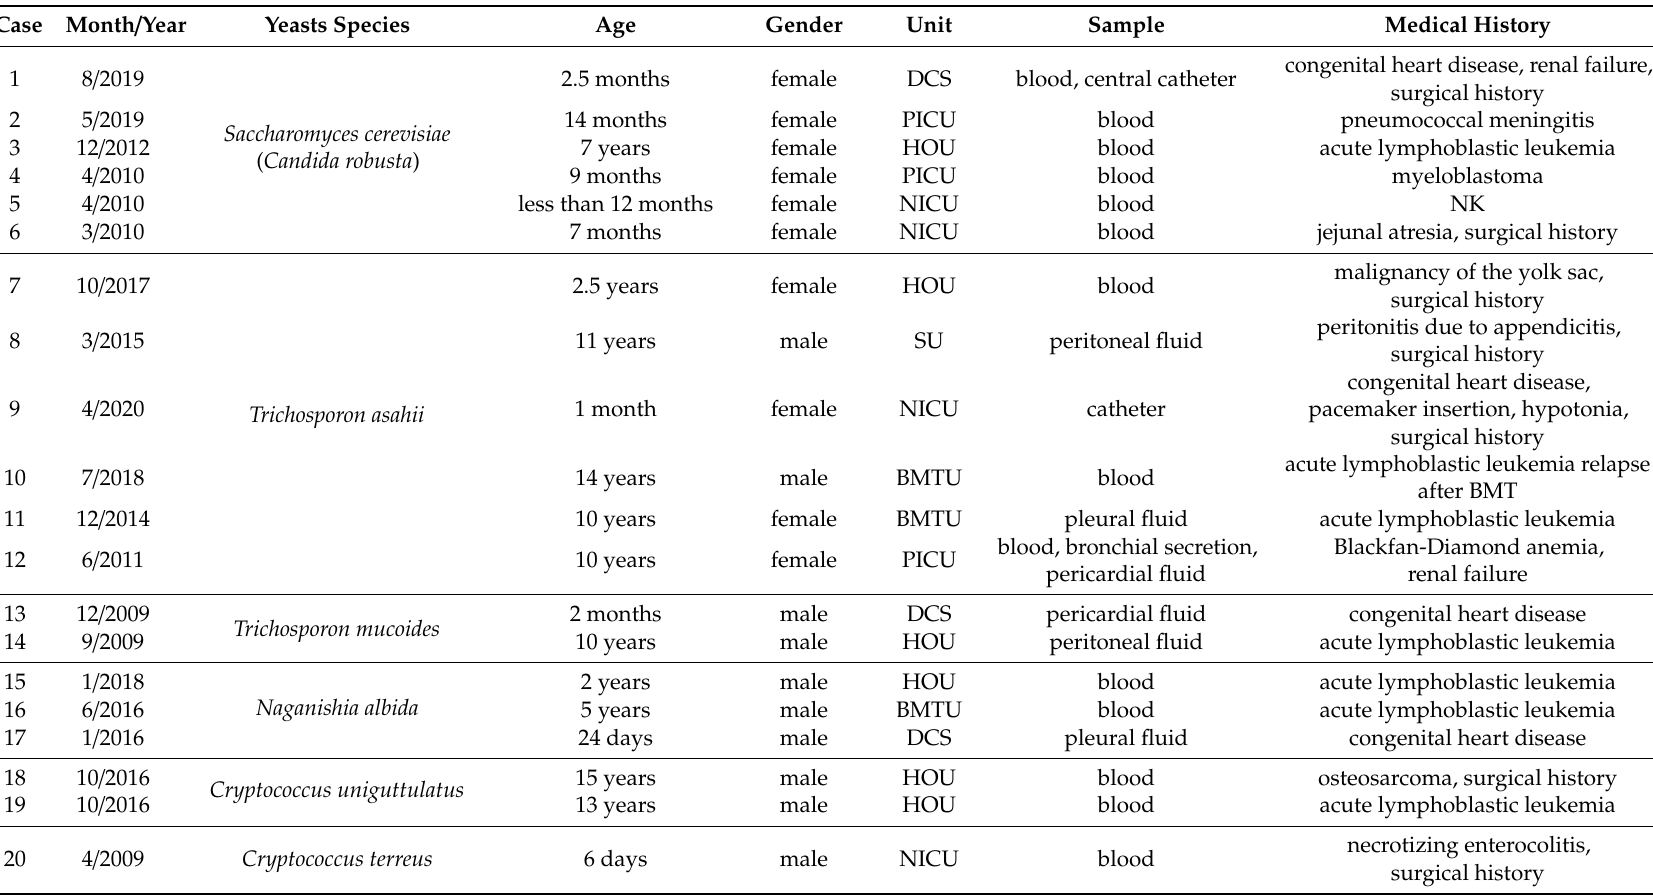
Table 1. Epidemiological and clinical characteristics and yeasts species isolated from neonates and children diagnosed with invasive fungal infections (IFI) in Athens, 6 / 2008–6 /